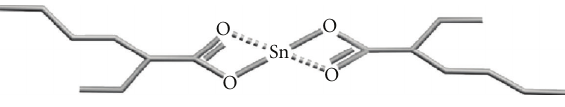
Figure 4: Tin (II)